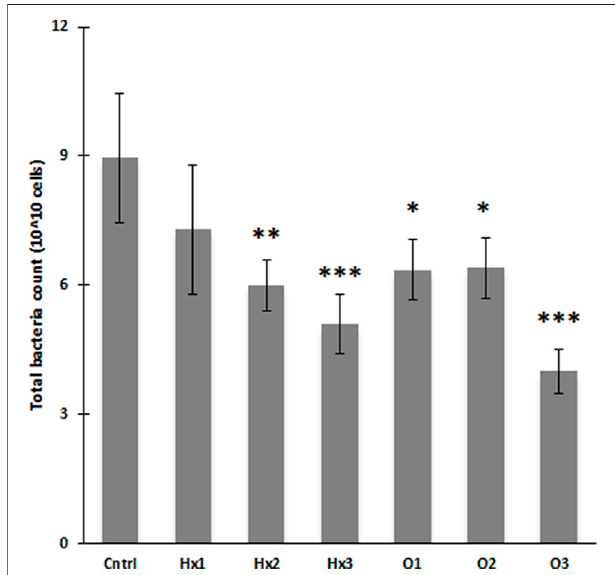
FIGURE4 | Flow cytometrically determined biovolumesastotal bacteria countsfordifferenttreatmentsaftertheincubation( n =4).Errorbarsrepresent the SDs and statistical signi fi cance deviation from control (* p ≤ 0.05; ** p ≤ 0.01; *** p ≤